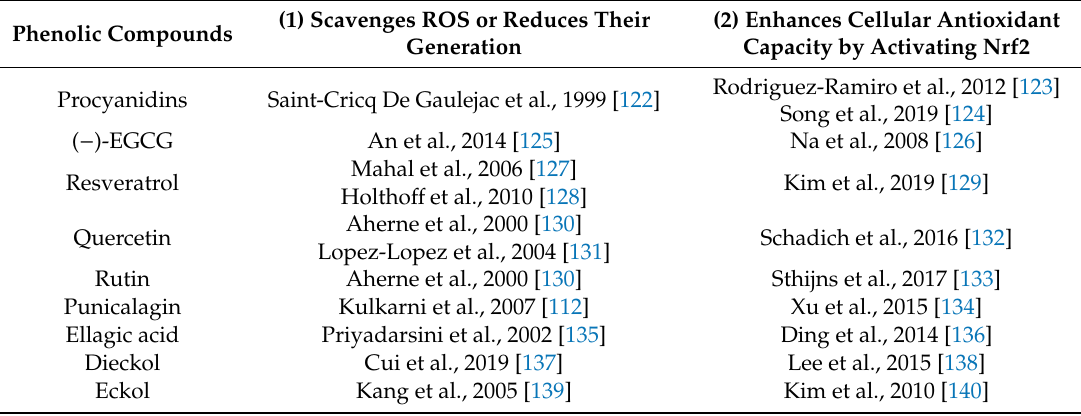
Table 2. Potential mechanisms of antioxidant action for plant-derived phenolic compounds. Phenolic